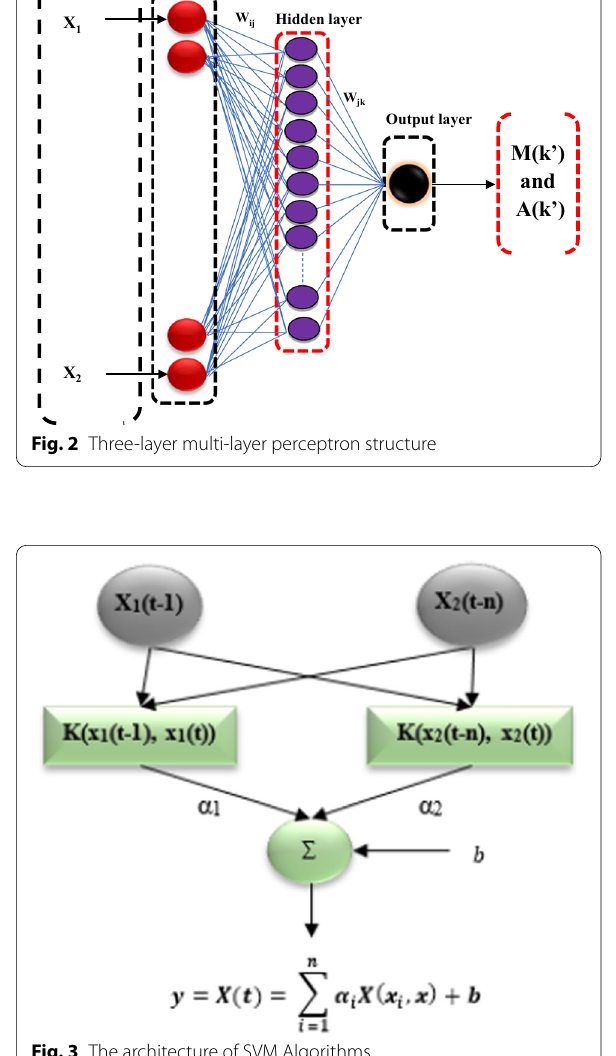
Fig. 3 The architecture of SVM